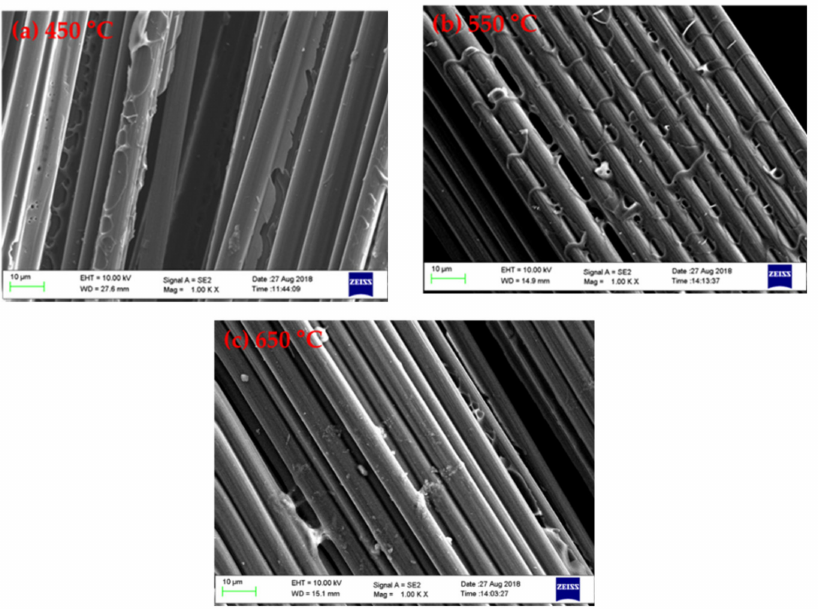
Figure 4. The surface morphology of carbon fibre after microwave pyrolysis at: ( a ) 450 ◦ C; ( b ) 550 ◦ C; and ( c ) 650 ◦